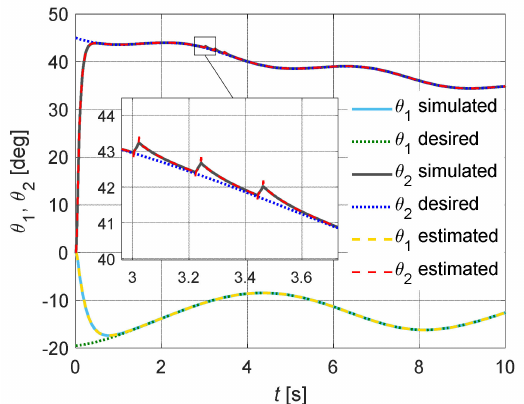
Figure 14. Angular displacements noised and estimated in azimuth and elevation—LQG control.